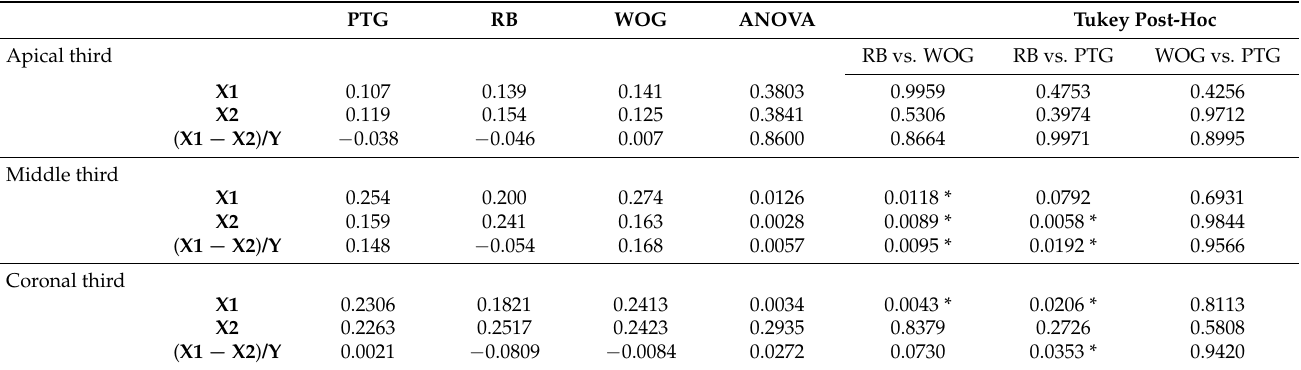
Table 4. Overall comparison of the mean values between PTG, RB, and WOG in the apical, middle, and coronal